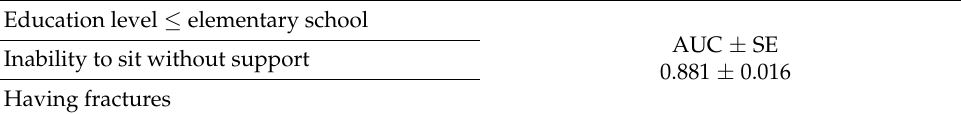
Table 5. Multivariable logistic regression results of modified physical disability components in validation